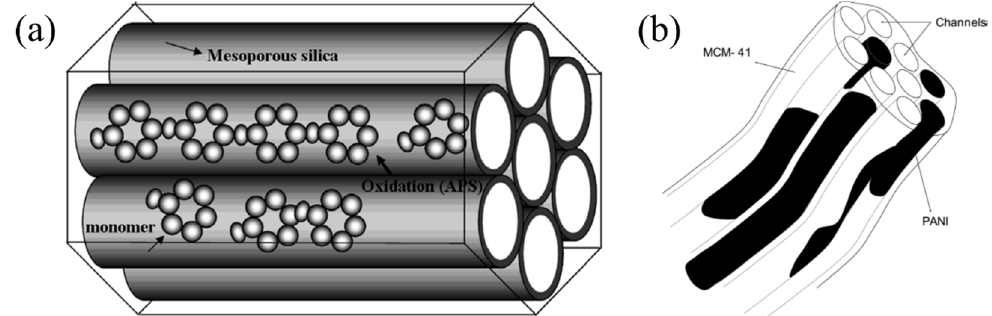
Figure 2. ( a ) Proposed schematic diagram of conducting polymer/Mobil Composition